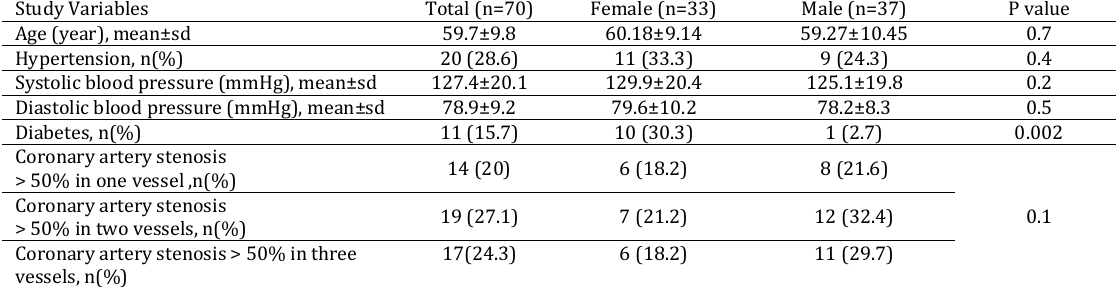
Table 1. Baseline characteristics of the patients Study